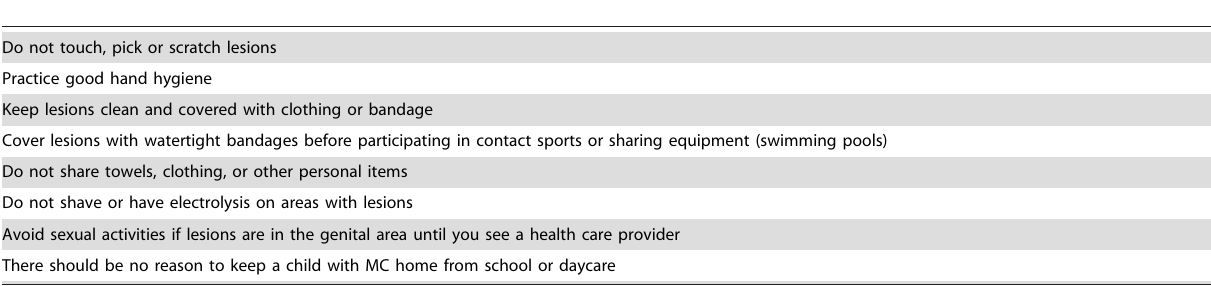
Table 6. CDC molluscum contagiosum transmission precaution recommendations.